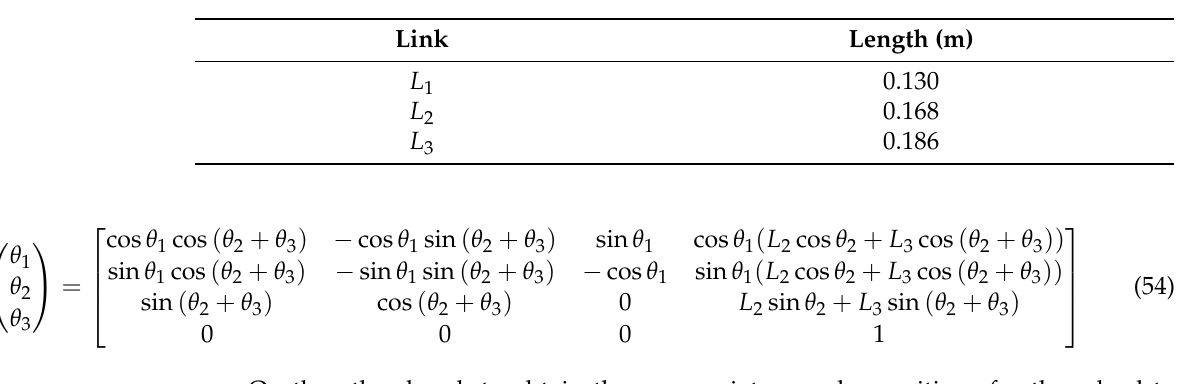
Table 3. Lengths of the leg